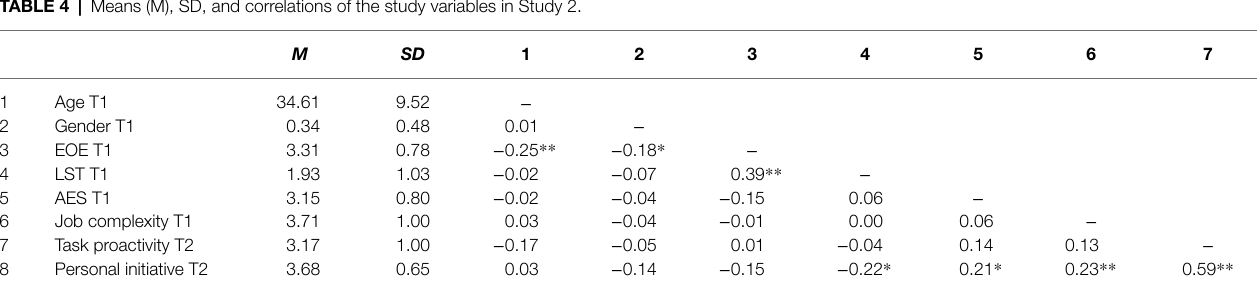
TABLE 4 | Means (M), SD, and correlations of the study variables in Study 2. M SD